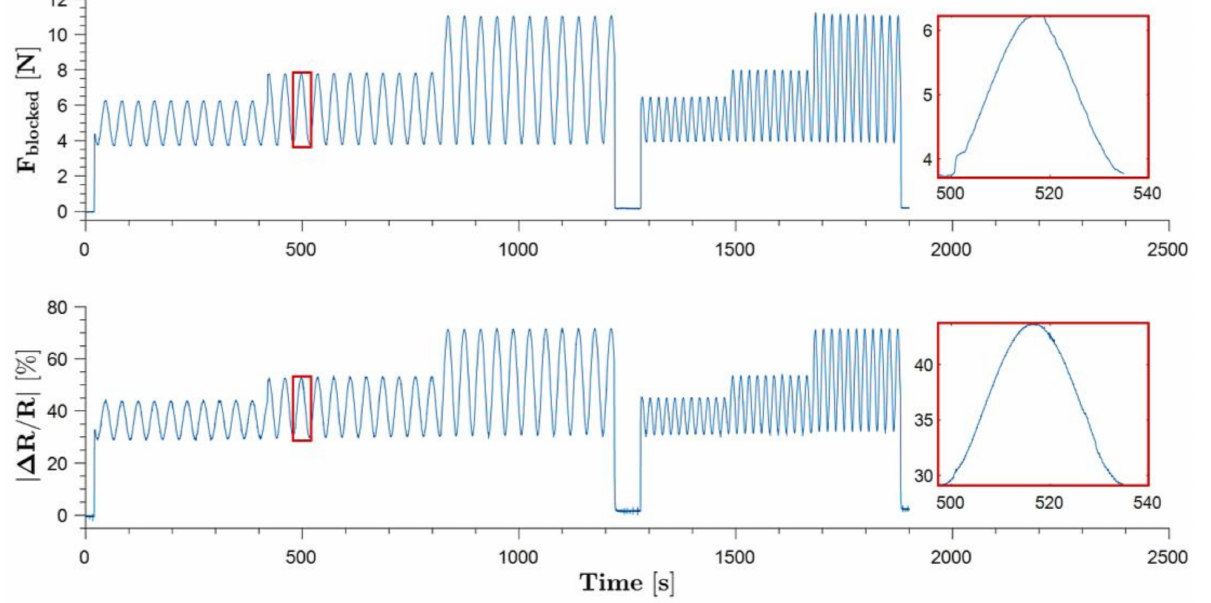
Figure 8. Behavior of SoHapS under cyclic loading at different amplitudes and frequencies (inset plots are provided for the period of a 0.027 Hz